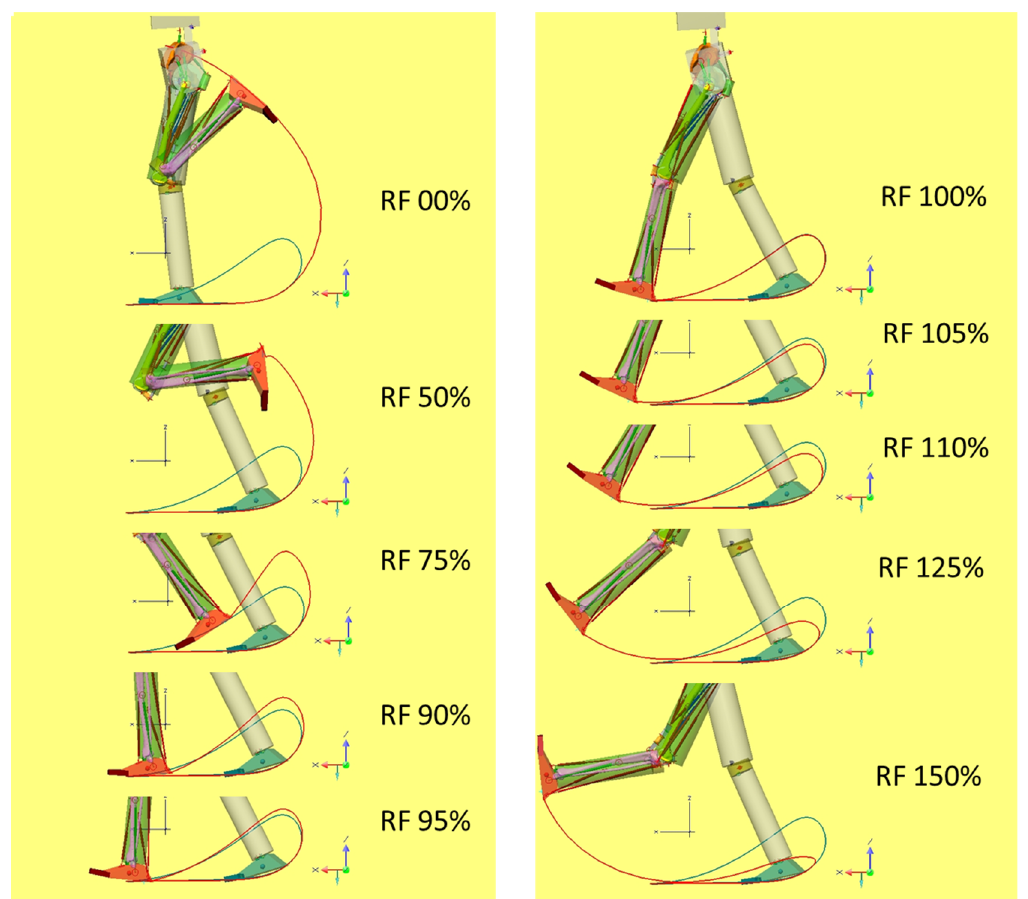
Figure 3. Left panel: kinematics resulting from decreasing RF force; right panel: kinematics resulting from increasing RF force. The model is represented in the position achieved at the end of stride time (100% stride time). The red and blue curves represent the trajectory of a point located on the heel of, respectively, the right side (unaffected, blue line) and the left side (our test limb, red line). The hip joint was fully compensated (hip kinematics imposed).